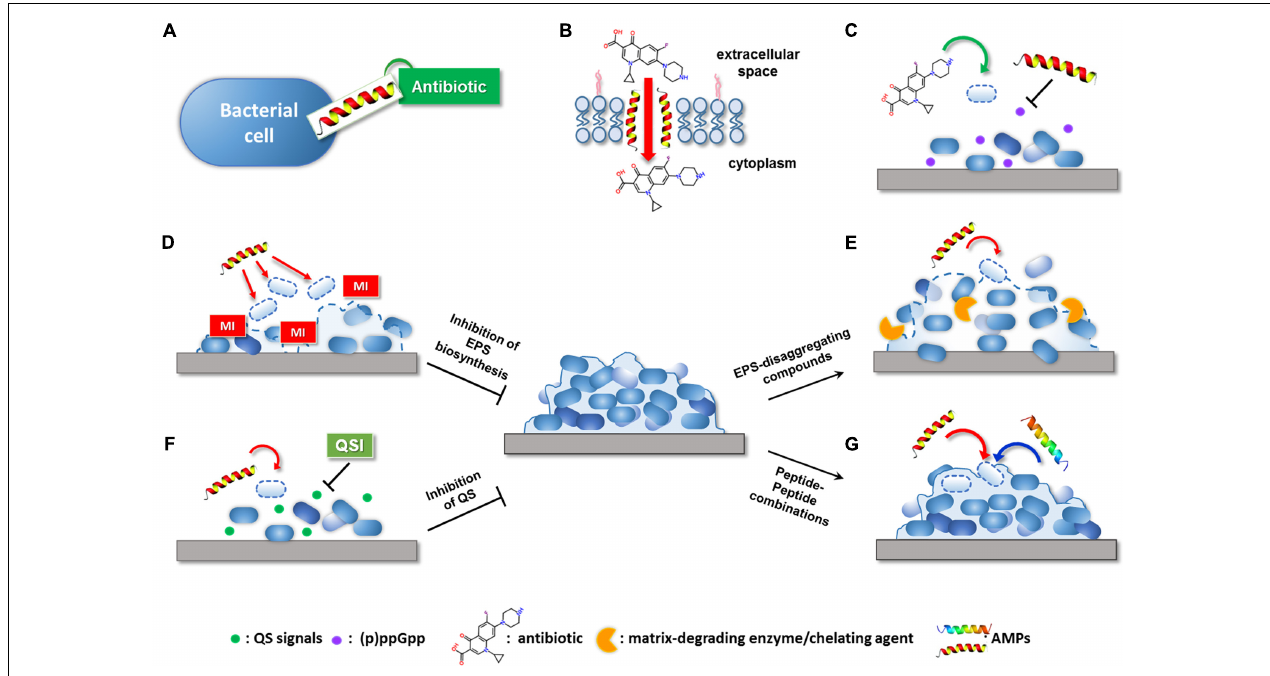
FIGURE 1 | Possible mechanisms of the synergistic activity of AMP-based combinations against bacterial biofilms. AMPs can potentiate the antibiofilm effect of conventional antibiotic by: (A) extending antibiotic spectrum of action; (B) promoting antibiotic intracellular uptake through membrane destabilization; (C) interfering with signaling molecules involved in biofilm formation. Compounds able to target the biofilm EPS can potentiate AMP activity by: (D) inhibiting matrix production in forming biofilms; (E) causing matrix disaggregation in preformed biofilms. (F) QSIs can facilitate the killing of early surface-colonizing bacteria by AMPs by interfering with signaling molecules implicated in biofilm formation. (G) AMPs may synergize with other AMPs with mechanisms still largely unknown. MI, matrix inhibitor; QSI, quorum sensing inhibitor. Dashed lines indicate killing of bacteria or inhibition/disaggregation of biofilm